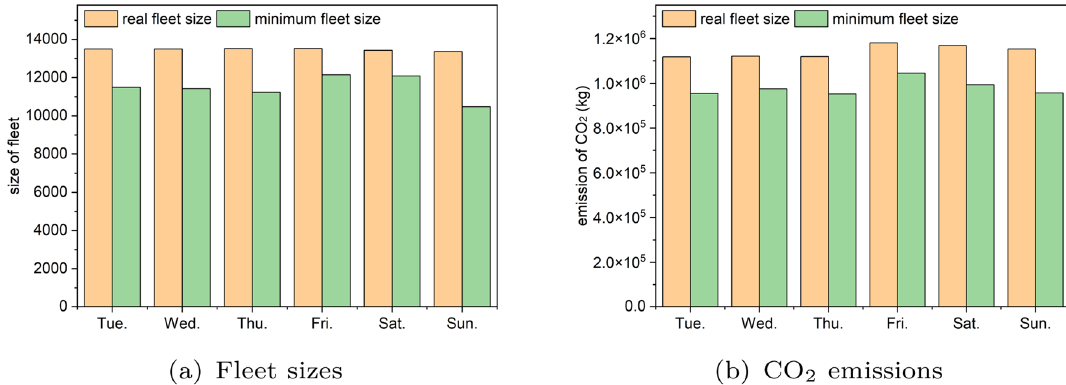
Fig. 23 Analyses of minimum taxi fleets